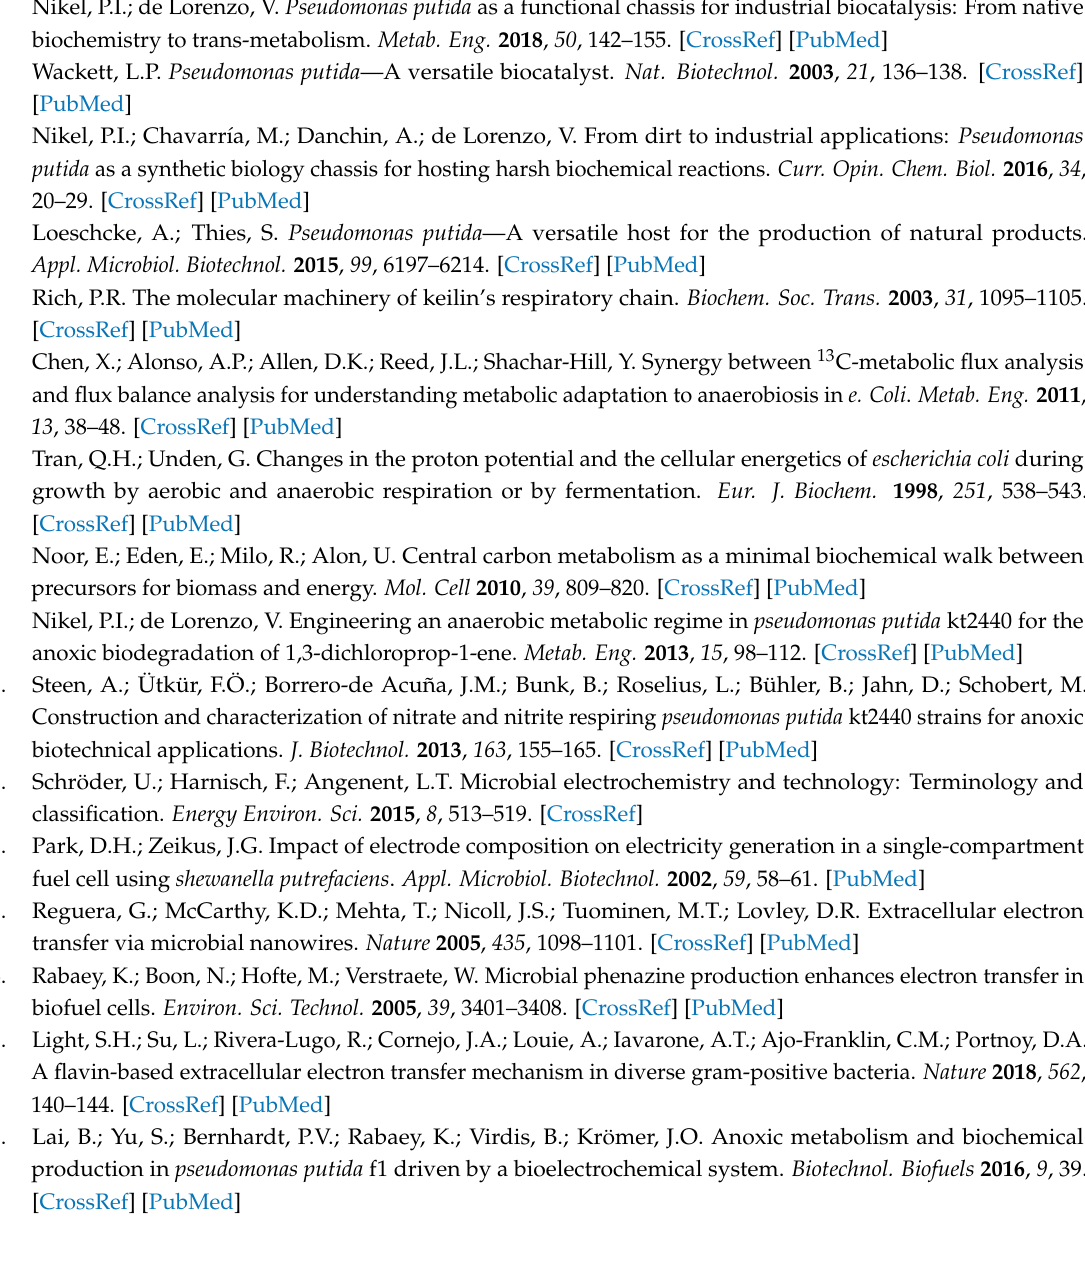
26/s1, Figure S1: Cyclic voltammetry characterization of carbon cloths with different pre-treatment methods, Figure S2: Growth property of Pseudomonas putida F1 in shake flasks with different gas-permeable stoppers in minimum mineral